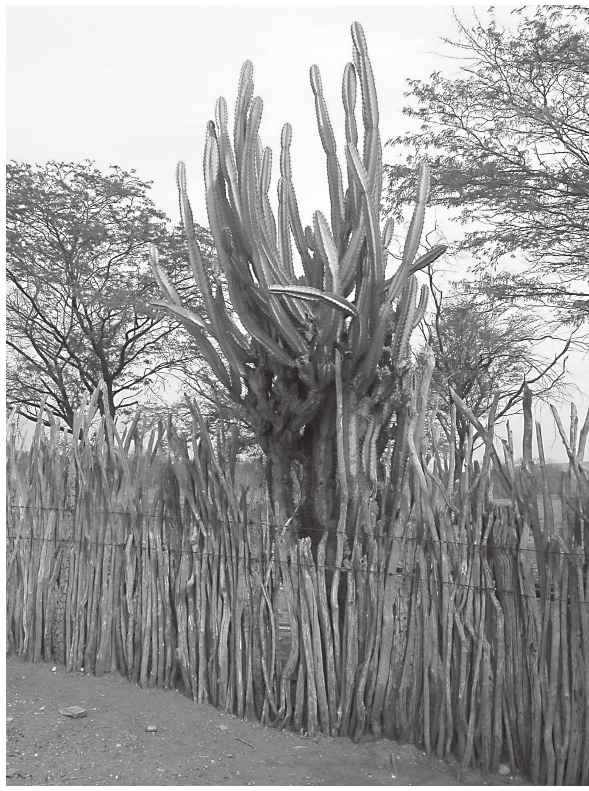
Fig. 2. – “Mandacaru” intercalé dans une